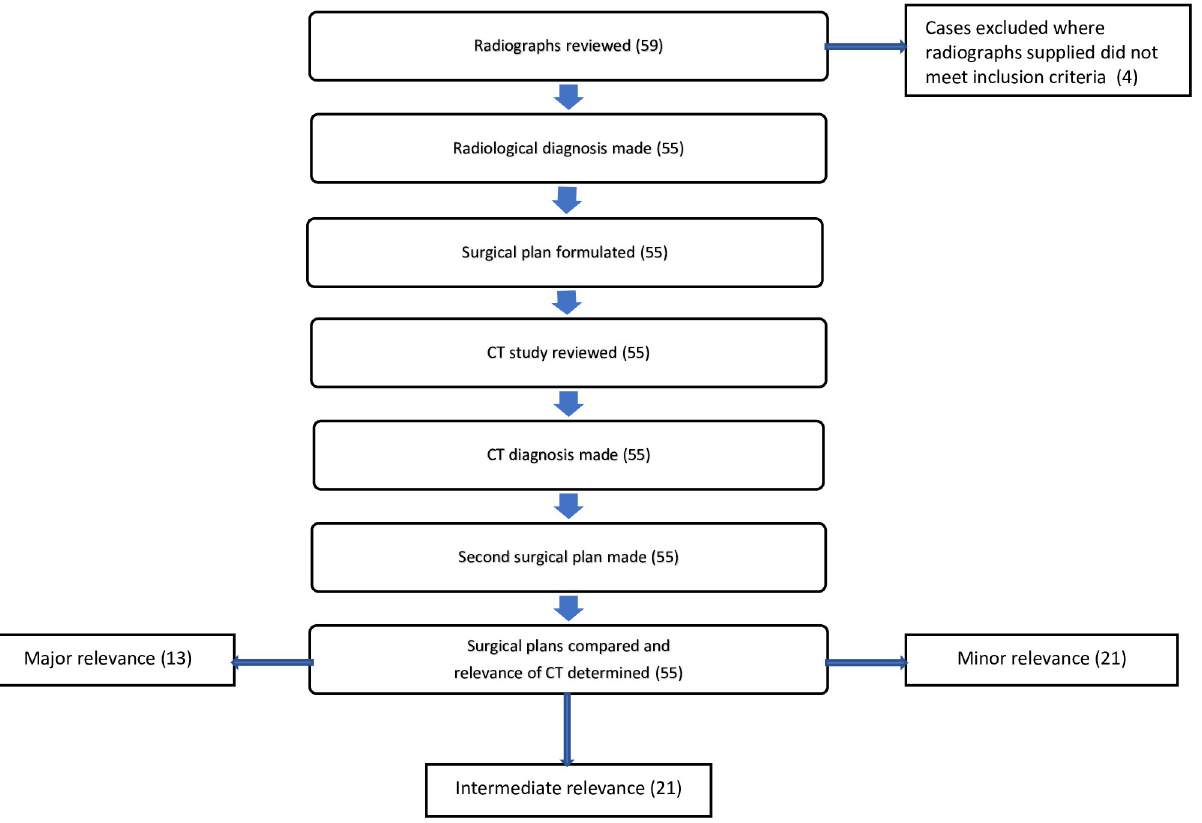
Fig 1. This diagram outlines the process by which decisions were made, relating to surgical planning and to the relevance of CT.